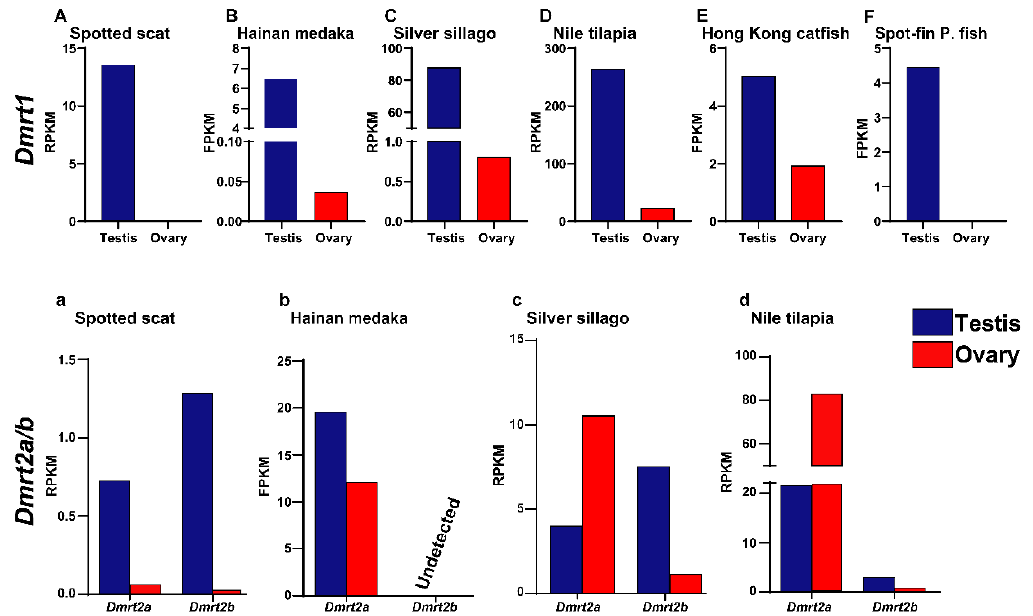
Figure 7. Gene expression in RPKM/FPKM obtained from gonad transcriptome data of ( A , a ) spotted